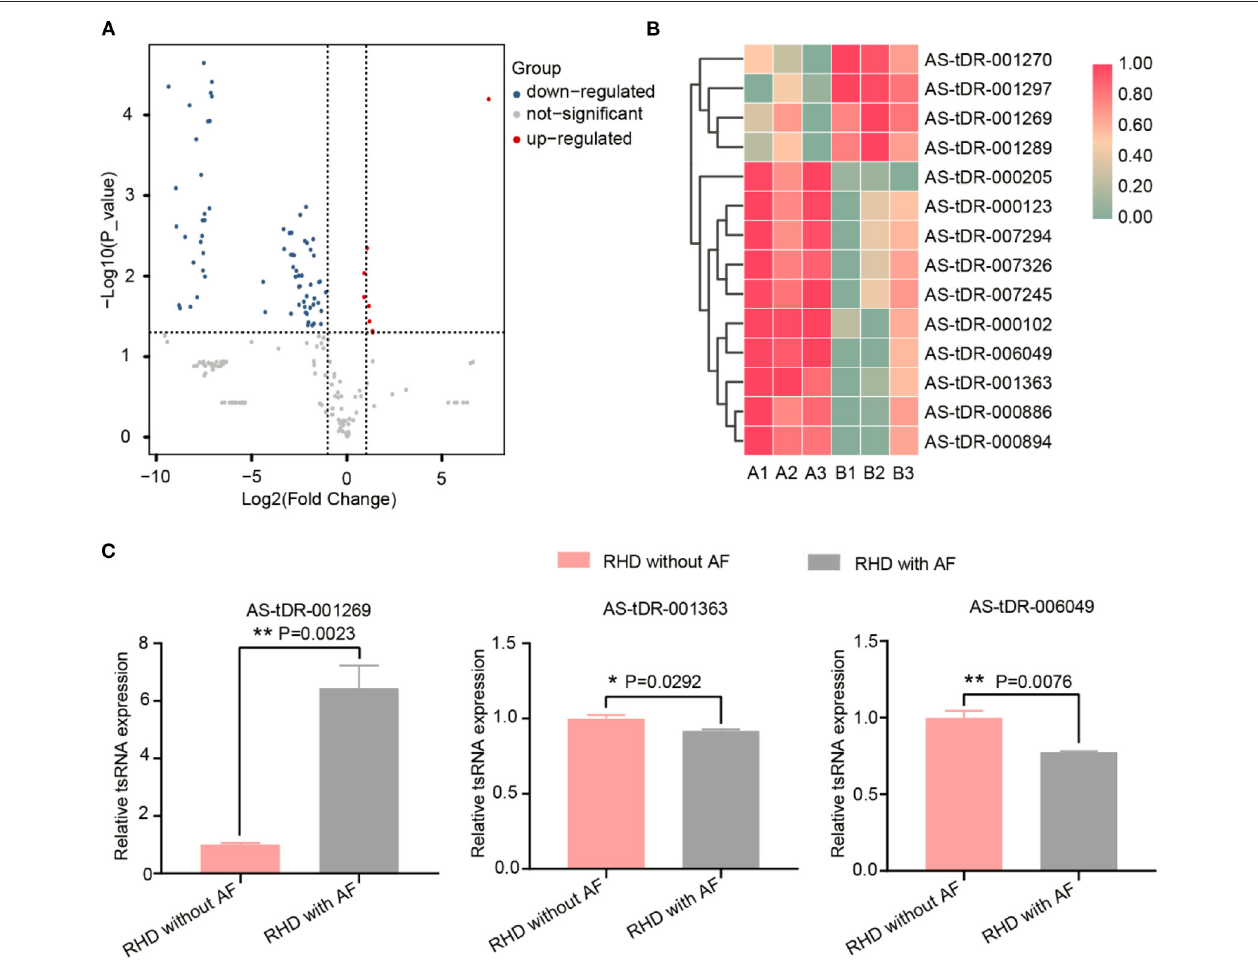
FIGURE 3 | The dysregulated tsRNAs expression profiles and the relative expression of selected tsRNAs were confirmed by qRT-RCR. (A) Volcano maps of differentially expressed tsRNAs. The volcano plot’s X and Y axes have values of log 2 (Fold Change) and –log 10 ( P _value). With a fold change > 2 and a P < 0.05, red/blue dots indicate statistically considerable differentially expressed tsRNAs (red depicts elevated expression while blue indicates decreased expression). No differentially expressed tsRNAs are indicated by gray dots. (B) The hierarchical clustering heat-map for the 14 aberrantly expressed tsRNAs (RHD without AF: A1, A2, A3; RHD with AF: B1, B2, B3). (C) The qRT-PCR results were consistent with the RNA-Seq data. AS-tDR-001269 ( P = 0.0023), AS-tDR-001363 ( P = 0.0292), AS-tDR-006049 ( P = 0.0076) were statistically different between RHD with the AF group and RHD without the AF group. Data were present as mean ± SEM ( n = 3 for each group). * P < 0.05 represent RHD with AF compared to RHD without AF; ** P < 0.01 indicated RHD with AF compared to RHD without AF. qRT-PCR, quantitative real-time PCR; RNA-Seq, RNA